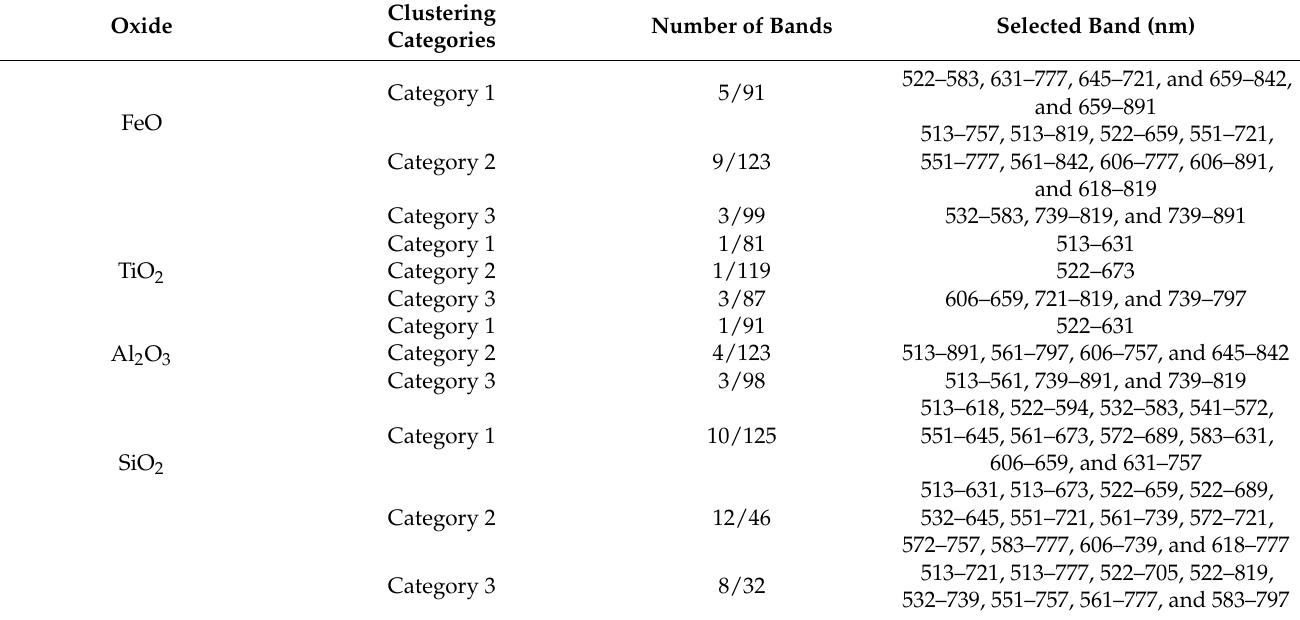
Table 3. Final screening results for feature